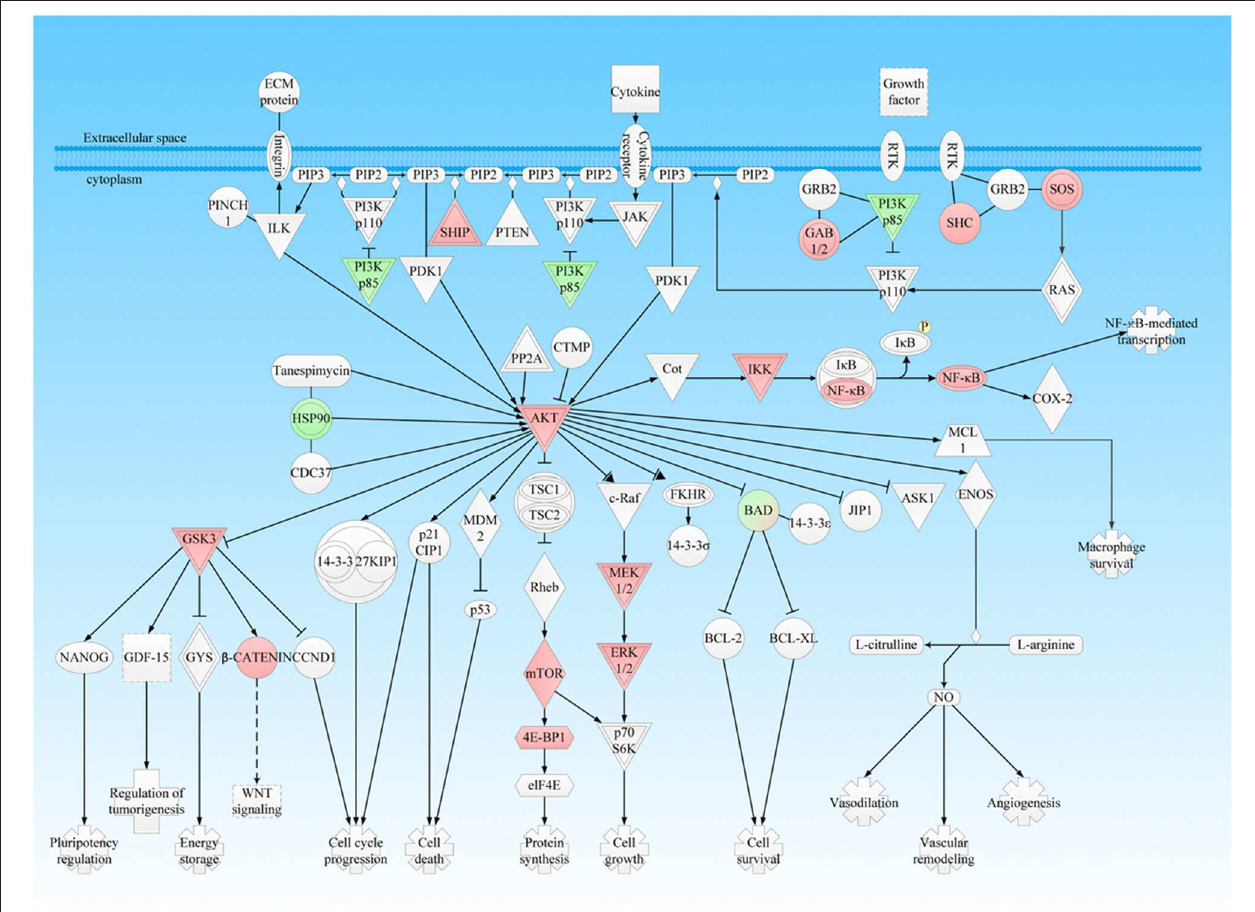
FIGURE 3 | PI3K-AKT signaling pathway was involved in NFPA. This pathway was derived from the IPA analysis results of multi-omics, and then it was modified and verified according to the PTMScan results of NFPAs compared to controls. The red color means upregulation of a molecule in NFPAs, and the green color means downregulation of a molecule in NFPAs. The gradient color degree means slightly different expression tendency of that molecule.